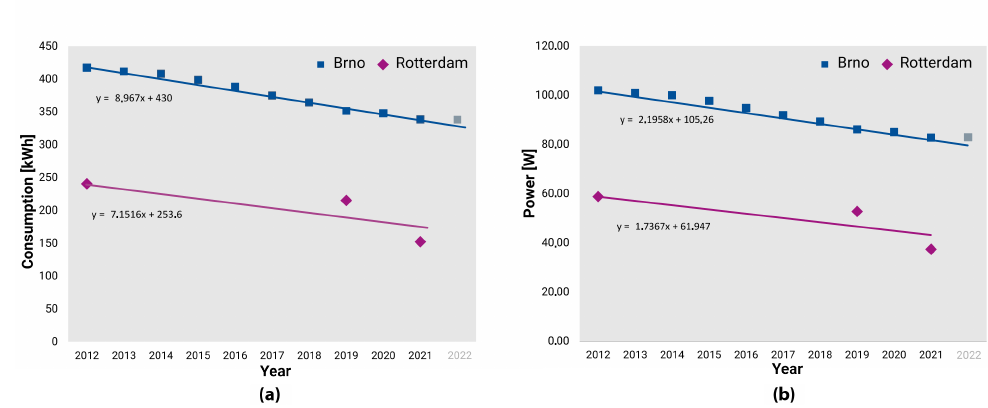
Figure 9. Public lighting consumption for Brno and Rotterdam: ( a ) Consumption per single light point. ( b ) Power per single light